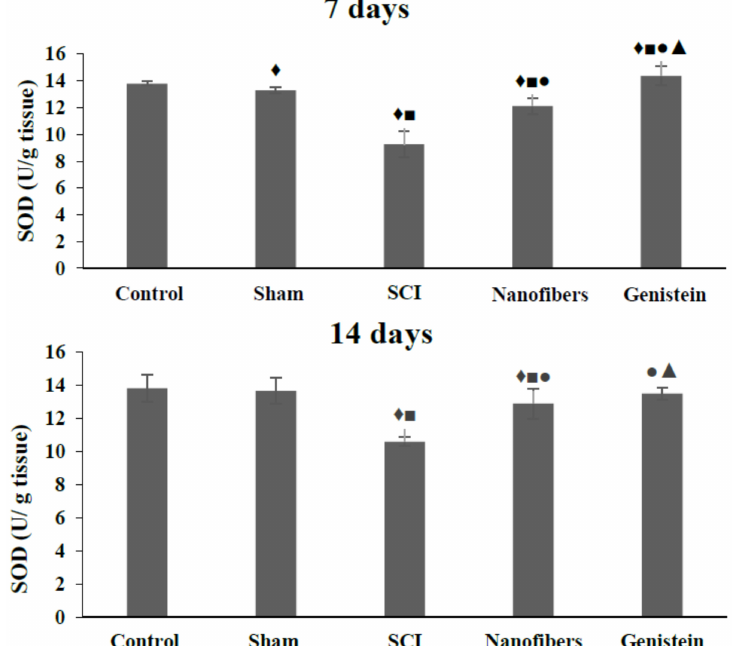
Figure 1. Super oxide dismutase (SOD) activity (U/g tissue) in spinal cord tissue. Genistein & Nanofibers increase super oxide dismutase (SOD) activity in spinal cord tissue of rats in the treatment groups when compared with control ( (cid:7) ) and sham groups ( (cid:4) ). Both treatment groups showed significant increase of SOD when compared with SCI group ( , (cid:78) ). Number of animals ( n = 5). Data shown as Mean ±